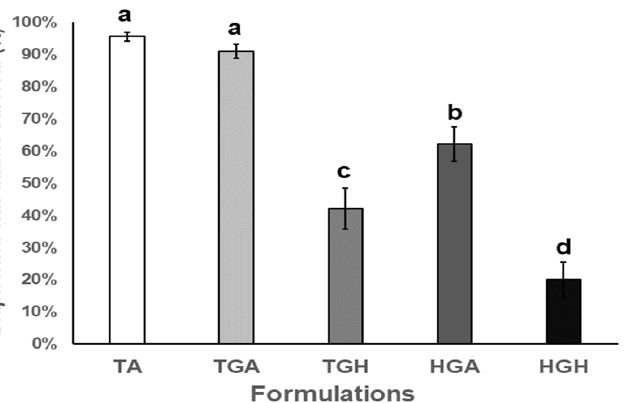
Figure 6. Diaphorina citri adults’ survival average in field after Hirsutella citriformis formulated co- nidia application by spraying. Absolute control = TA, Acacia gum control = TGA, Hirsutella gum control = TGH, formulation with Acacia gum = HGA, formulation with Hirsutella gum = HGH, Dif- ferent letters indicate significant statistical differences, and bars indicate the standard error of the mean (Tukey test).